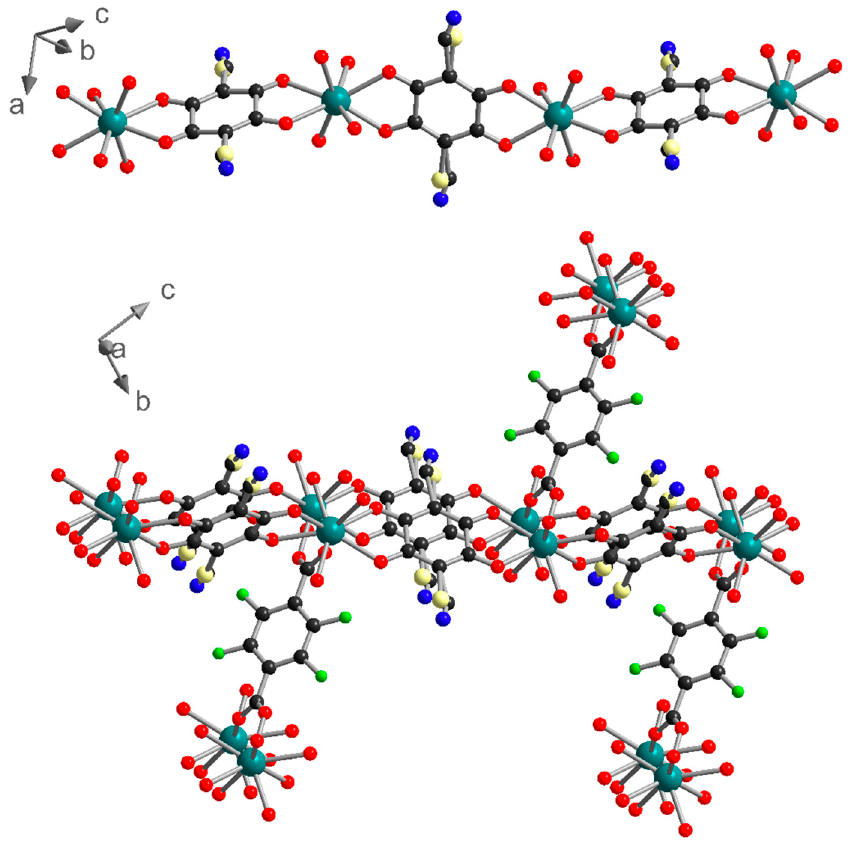
Figure 2. 1D chain of Yb-ClCNAn 2 − ( top ) and 3D network made by the connection of 1D chains with F 4 BDC 2 − ligands ( bottom ) in 1 . Color code: C (black), O (red), N (blue), F (green), Cl (light yellow), Yb (teal).